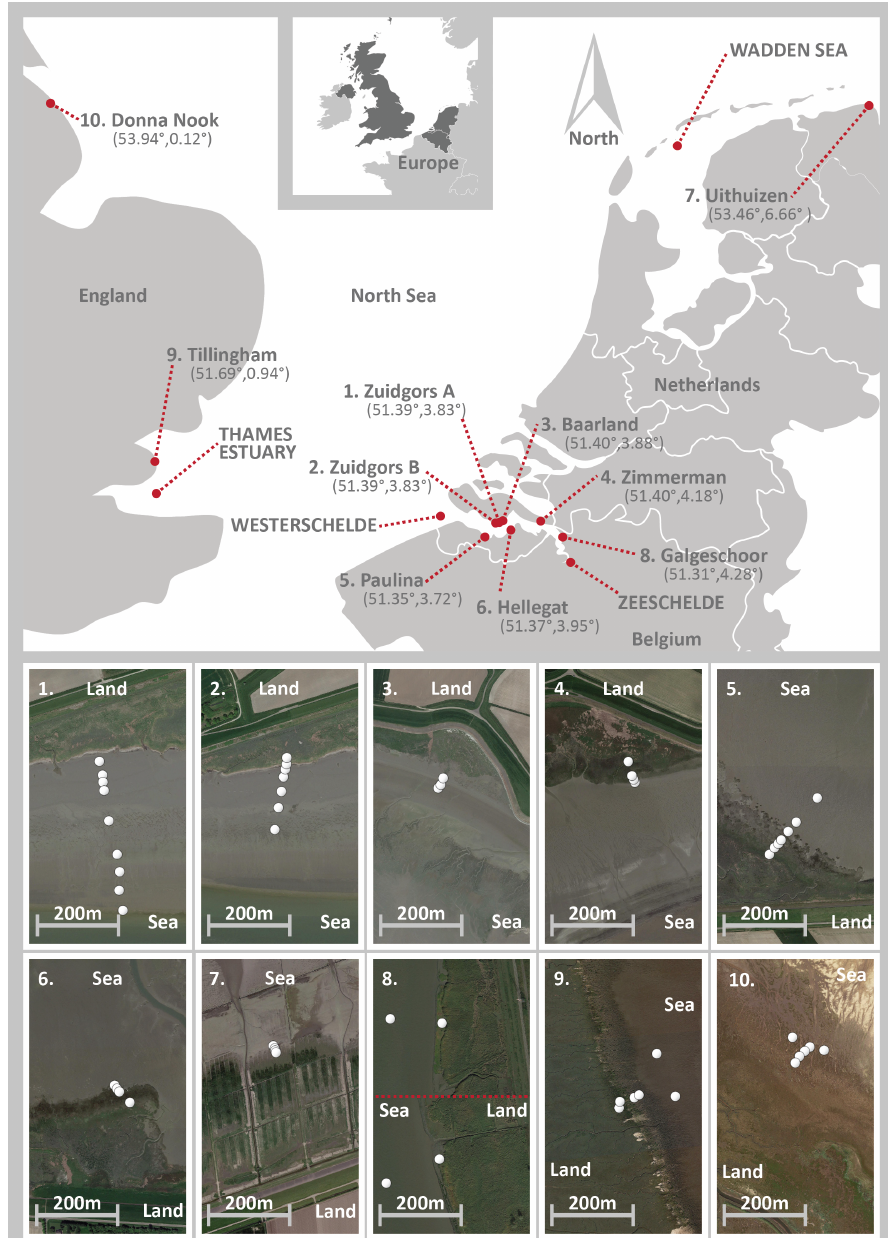
Figure 1. Locations and an overview of the observation sites in the Westerschelde and Wadden Sea in the Netherlands, Zeeschelde in Belgium, and the Thames and Humber estuaries in the United Kingdom. The lower 10 panels are the deployments of the SED sensor stations (white dots) at the observation sites. The GPS coordinates of all SED sensor stations are included in the data file. In panel 8, the maps of the north and south measuring transects at site 8 (Galgeschoor) are bordered by a red dot line. Source of aerial images: © Google Earth.